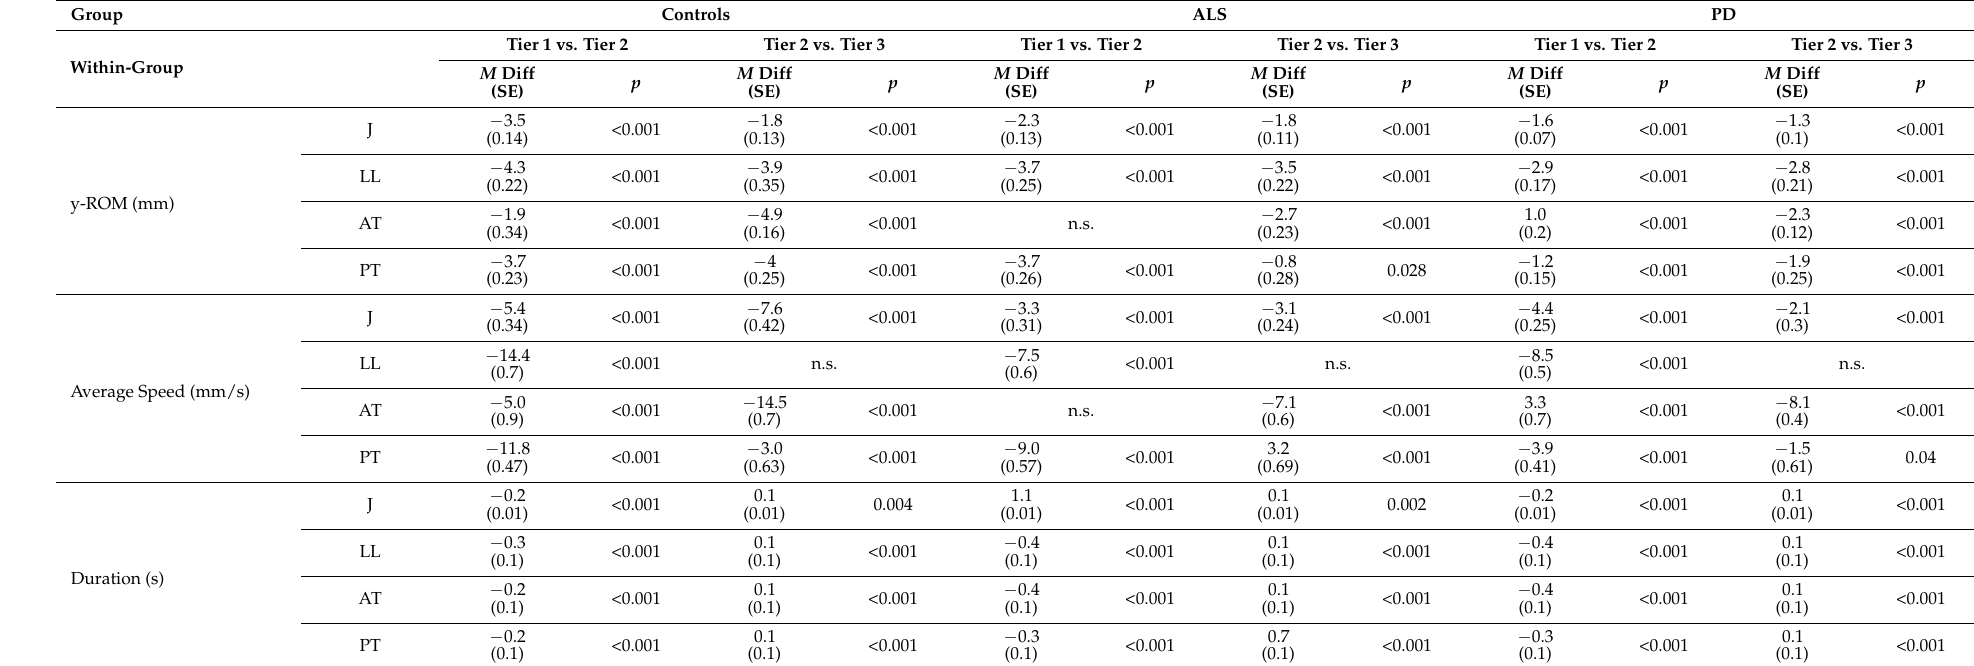
Table 5. Results of post hoc analyses for tier x group interactions (i.e., within-group effects). Group Controls ALS PD Tier 1 vs. Tier Within-Group